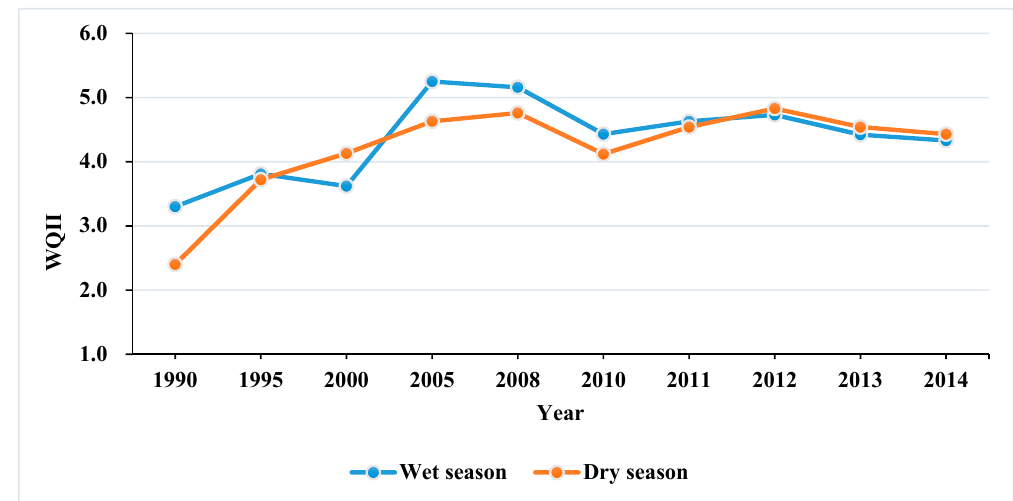
Figure 3. Comparison of water qualities between the wet season and dry season between 1990 and 2014 in the Qinhuai River, East China.